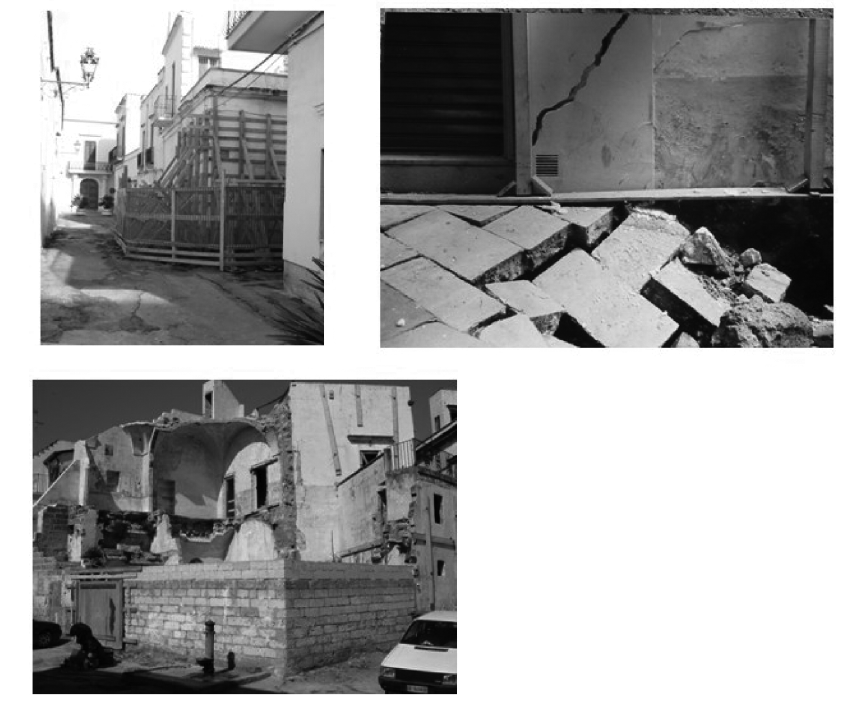
Fig. 1. Photos of soil subsidence in urban